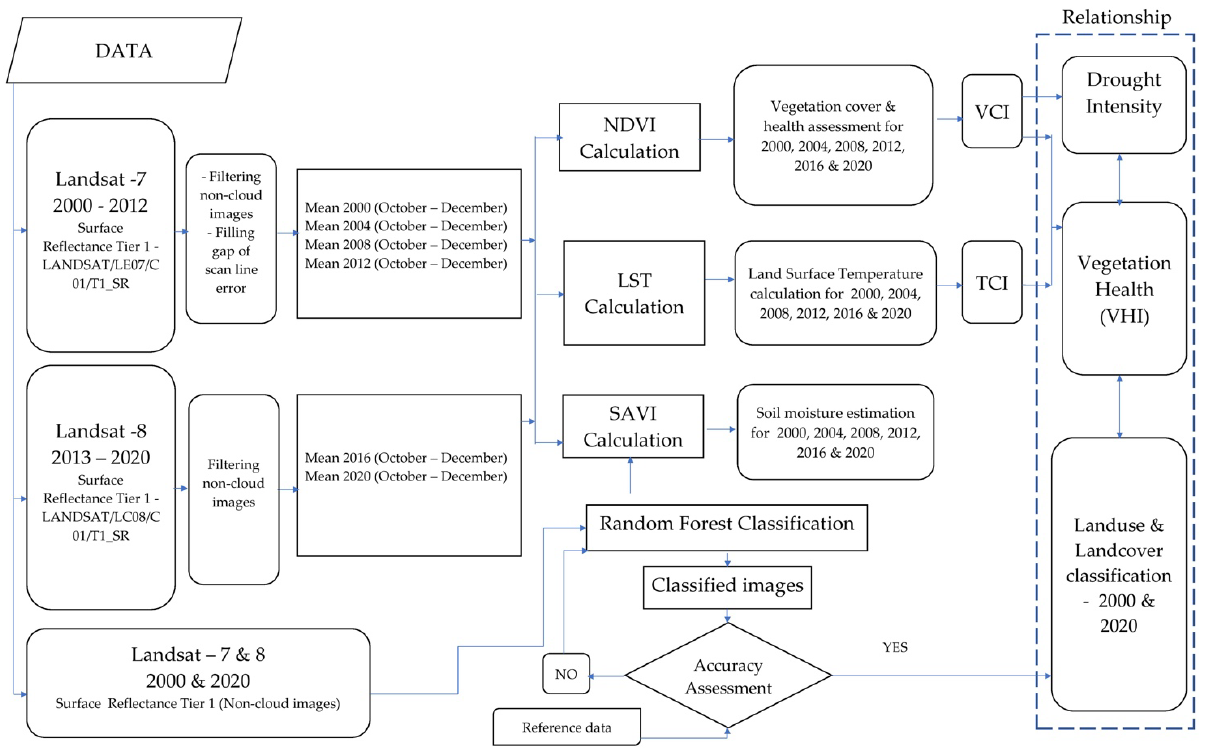
Figure 2. Methodology for analyzing landscape change and vegetation health (productivity) (NDVI: Normalized Difference Vegetation Index; VCI: Vegetation Condition Index; LST: Land Surface Tem- perature; TCI: Temperature Condition Index; VHI: Vegetation Health Index; LULC: Land-use and Land cover).